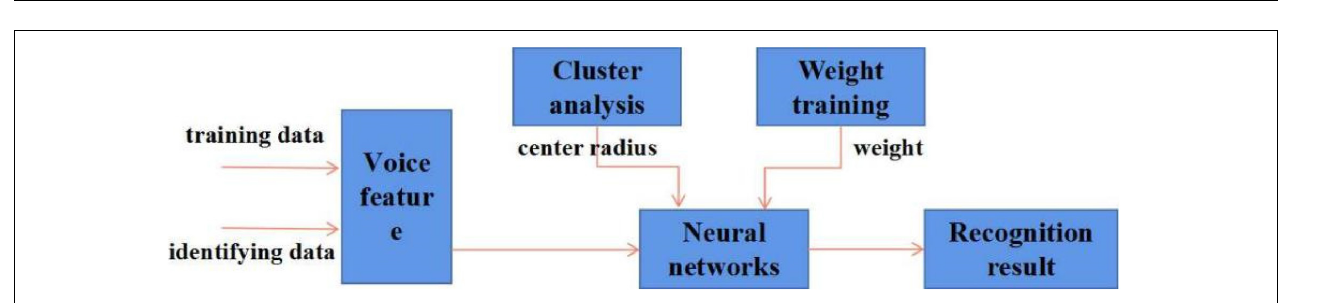
FIGURE 8 | Schematic diagram of the composition of the HMM model.